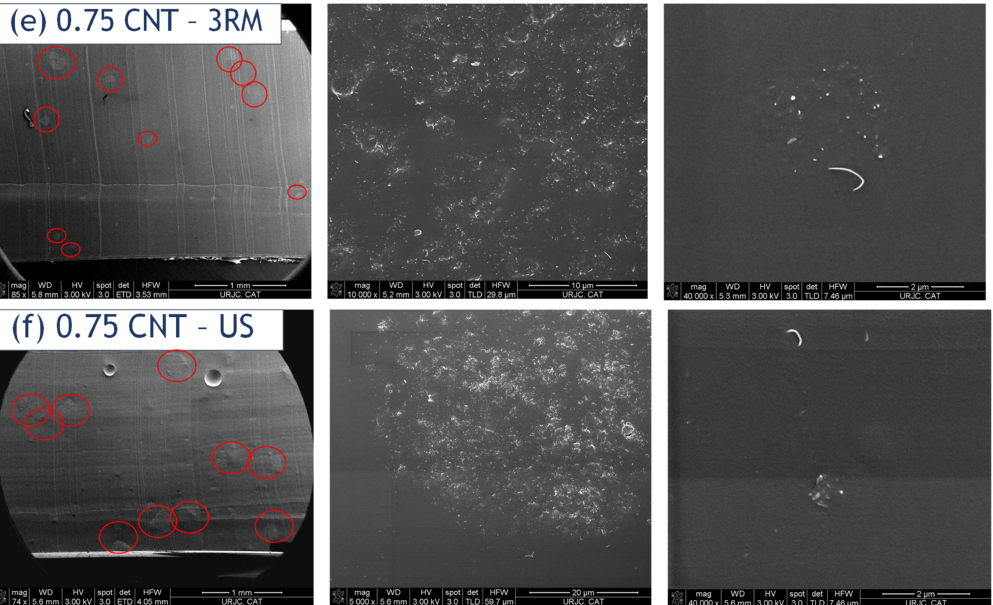
Figure 4. FEG-SEM images of the CNT-PDMS nanocomposites at ( a , b ) 0.4, ( c , d ) 0.5, and ( e , f ) 0.75 wt.% CNT as a function of dispersion procedure (US and 3RM). The left, center, and right images are at 70, 1000, and 40,000 magnifications, respectively. The areas highlighted in red denote the presence of larger CNT